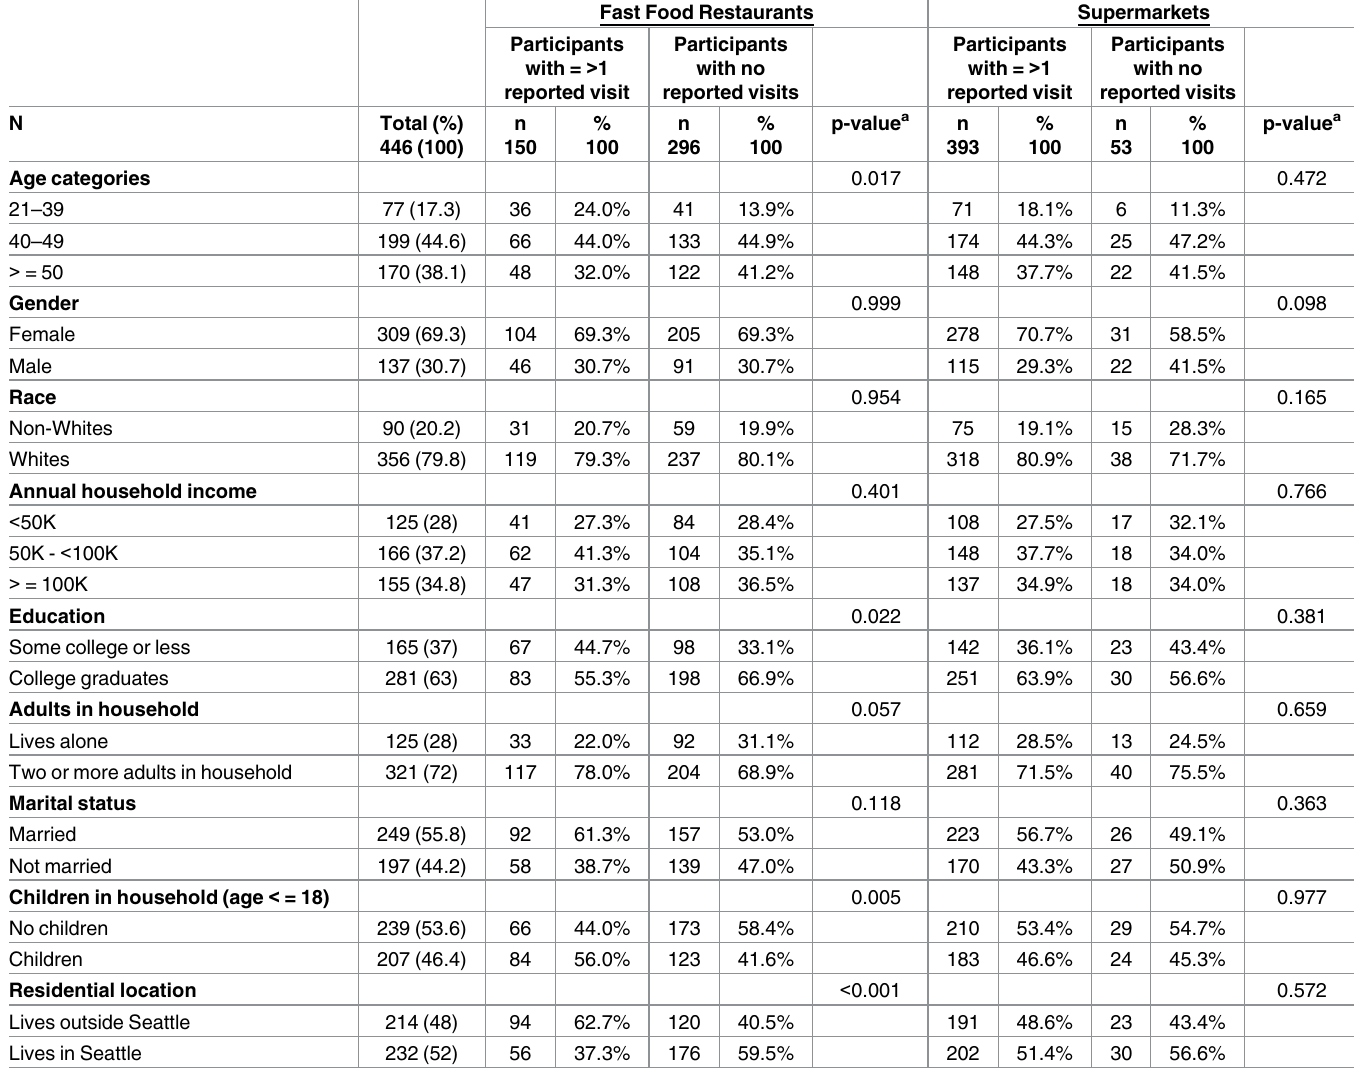
Table 1. Sample by reported visits to fast food restaurantsand